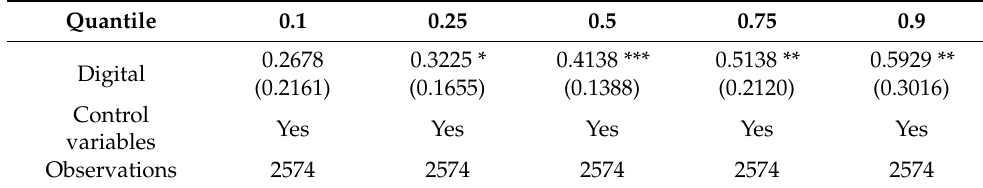
Table 3. Quantile regression results.